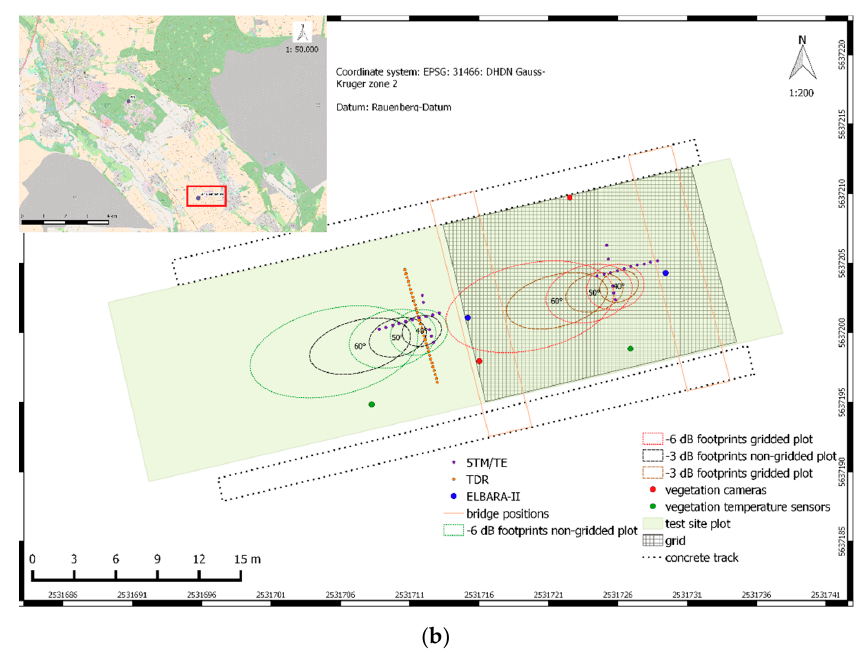
Figure 1. Picture of the experimental setup with the radiometer fixed on a moving bridge measuring above two plots, i.e., a plot with the soil covered by a reflector (metal grid) with the vegetation growing through the grid (gridded plot, with a mesh-grid size of about 1 cm) and a plot with the soil not covered by a reflector (non-gridded plot) within a homogenous wheat stand ( a ); sketch of the exact locations of the radiometer antenna with the corresponding − 3 dB and − 6 dB footprints of the radiometer, the bridge positions, and the locations of the in situ soil and vegetation sensors ( b ). L-band passive microwave remote sensing measurements were performed with the ELBARA-II radiometer at a frequency of 1.4 GHz. The measurements were performed at horizontal ( p = H) and vertical ( p = V) polarization ( p ) using a 3 s integration time to provide an accuracy of about 1 K. The with symmetrical and identical beams and a − 3 dB full beam width of 23° in the far field. A detailed